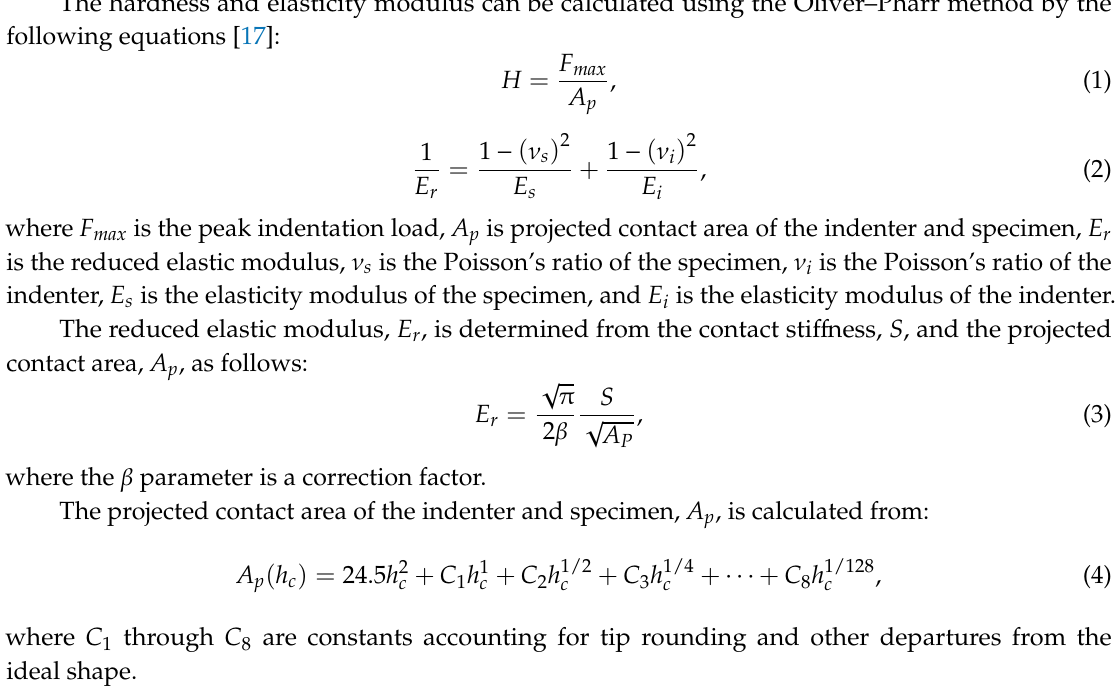
Figure 3. Typical load-indentation depth curve.